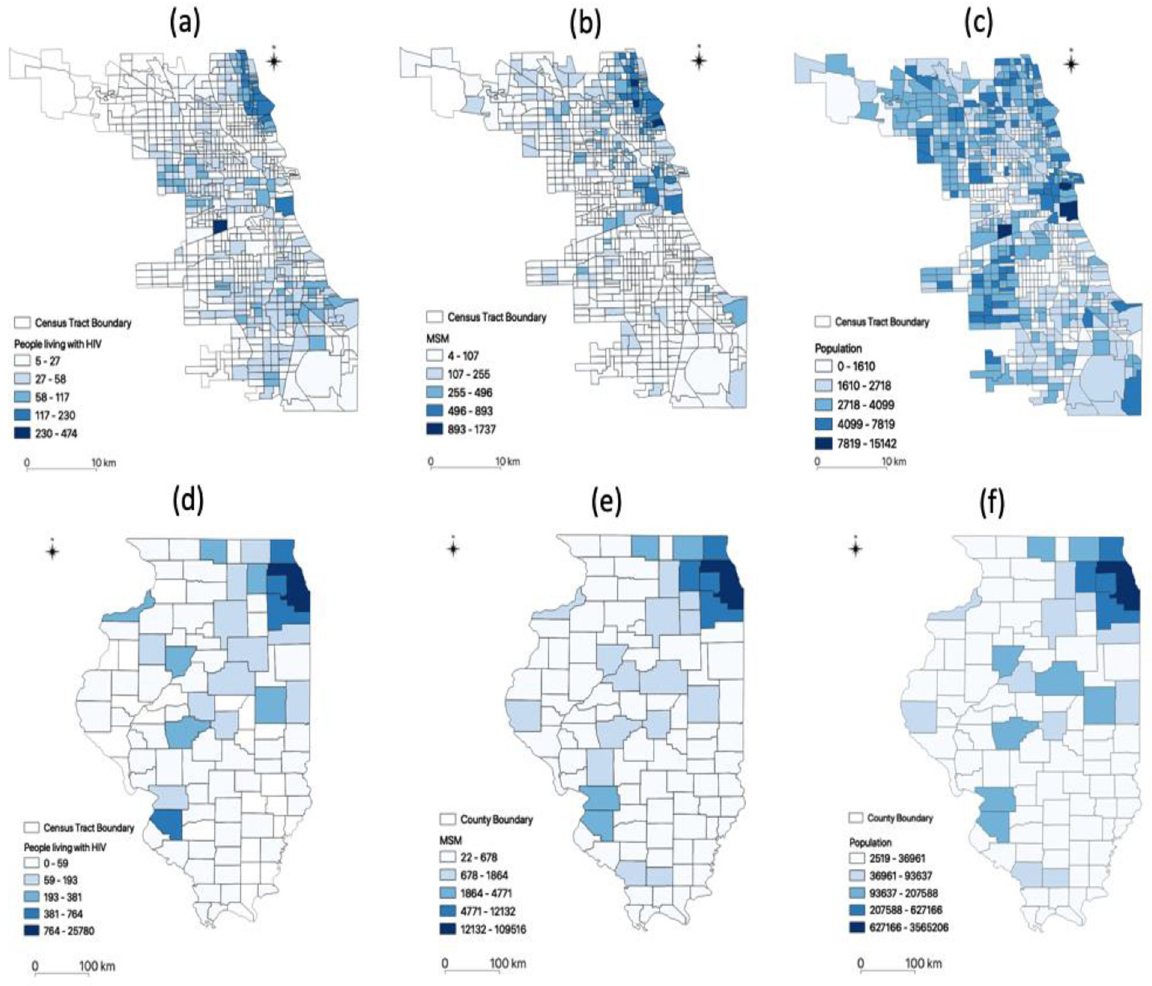
Fig 2. Three types of population in Chicago and Illinois. (a) PLWH in Chicago; (b) population (aged 15 to 64) in Chicago; (c) MSM in Chicago; (d) PLWH in Illinois; (e) general population (aged 15 to 64) in Illinois; and (f) MSM in Illinois.